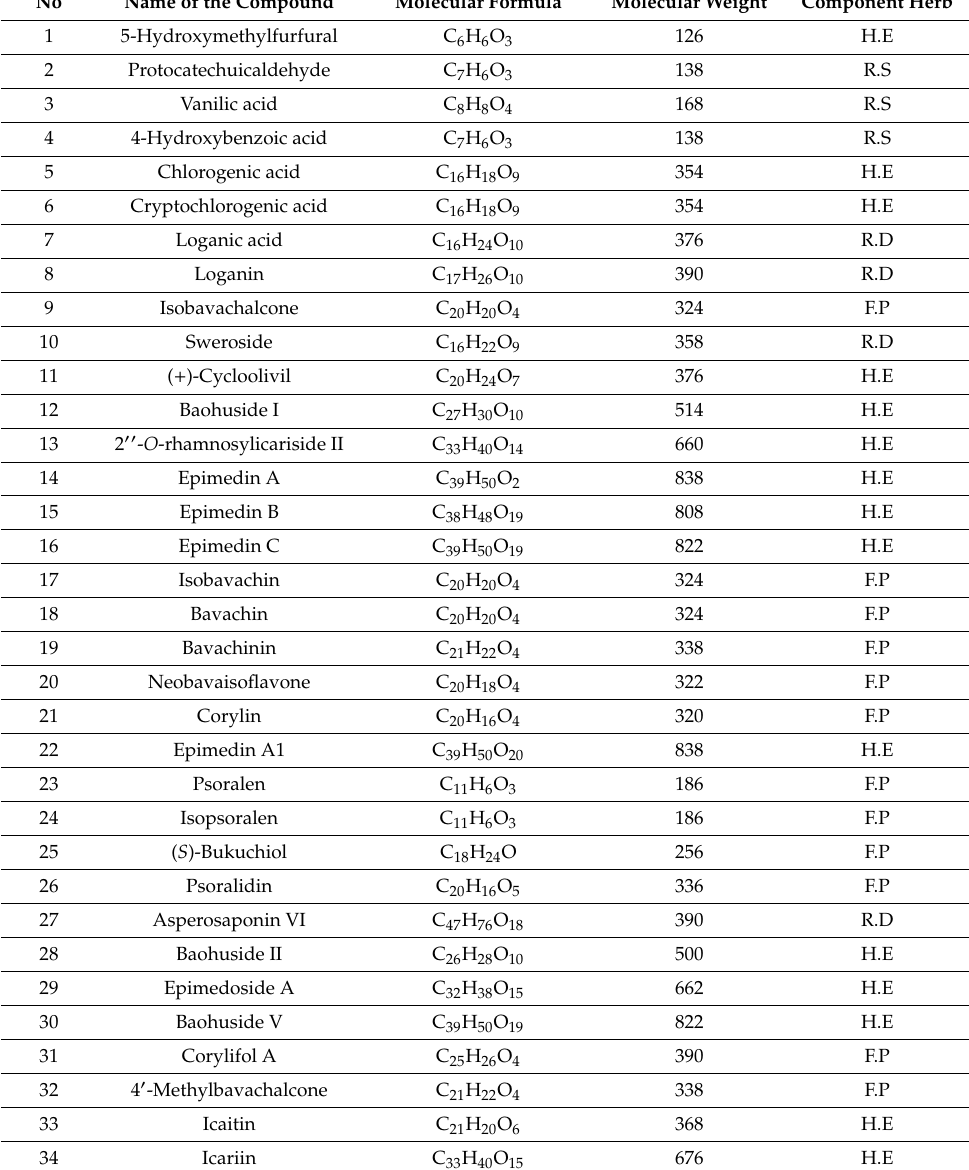
Table 2. List of 34 tested Traditional Chinese Medicine (TCM) compounds extracted from XLGB with their chemical formula, molecular weight and component